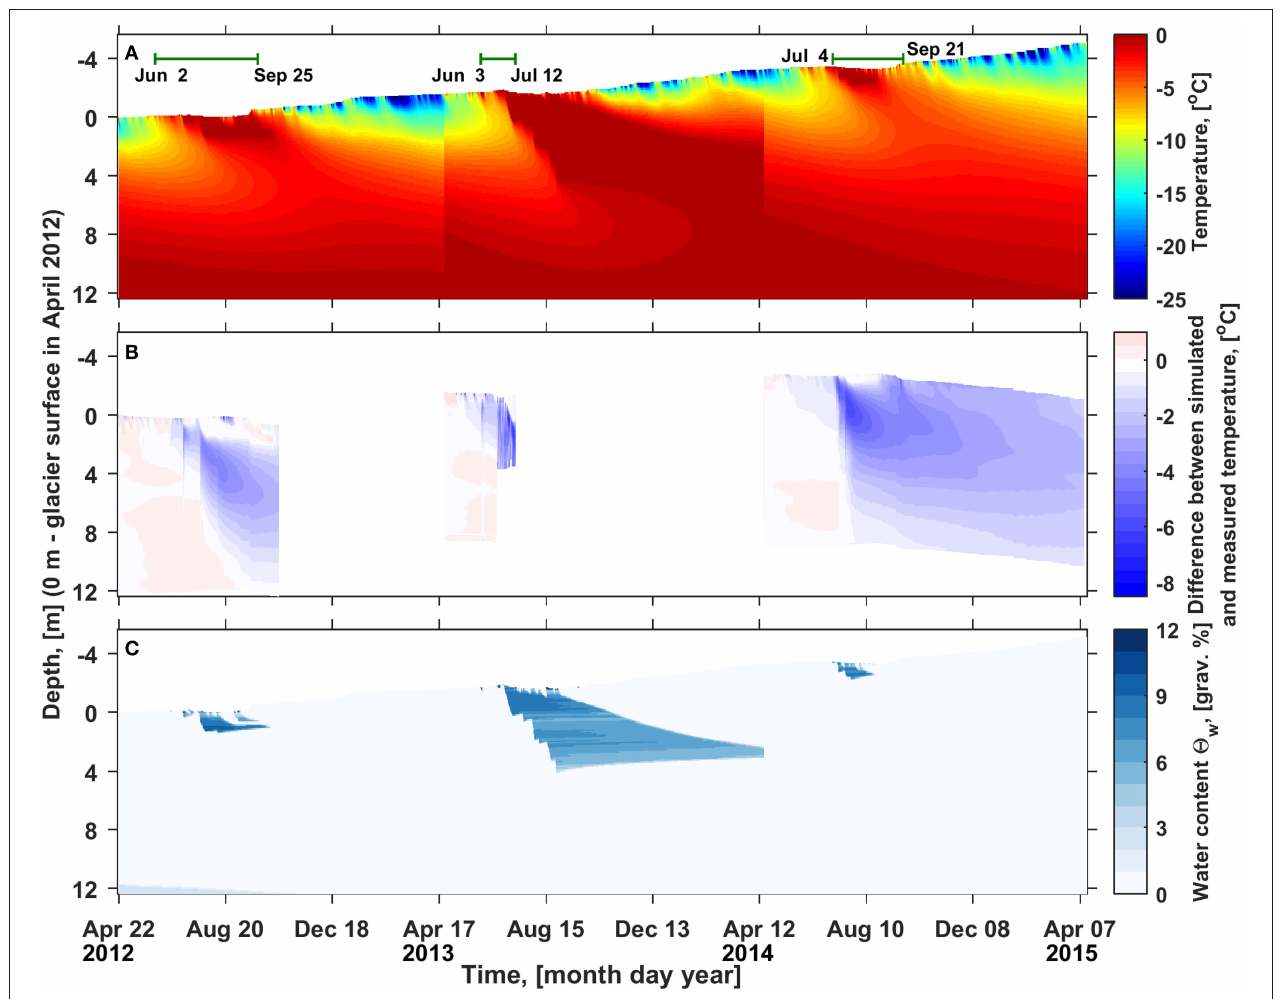
FIGURE 10 | (A) Evolution of the snow and firn temperature simulated using E 0 Wm − 2 and the default water infiltration scheme. Green bars in the upper part of + = the panel mark the time intervals used in calculations presented in Figure 11 . Resetting the simulated temperature profile to the measured values on the 23rd, 18th, and 16th April 2013, 2014, and 2015, respectively causes the sudden shifts in temperature evolution. (B) Difference between the simulated (A) and measured ( Figure 8A ) temperature evolution. Values larger than 1 ◦ C constitute ca 0.33 % and are shown as 1 ◦ C. (C) Evolution of the simulated gravimetric water content ( 2 w )